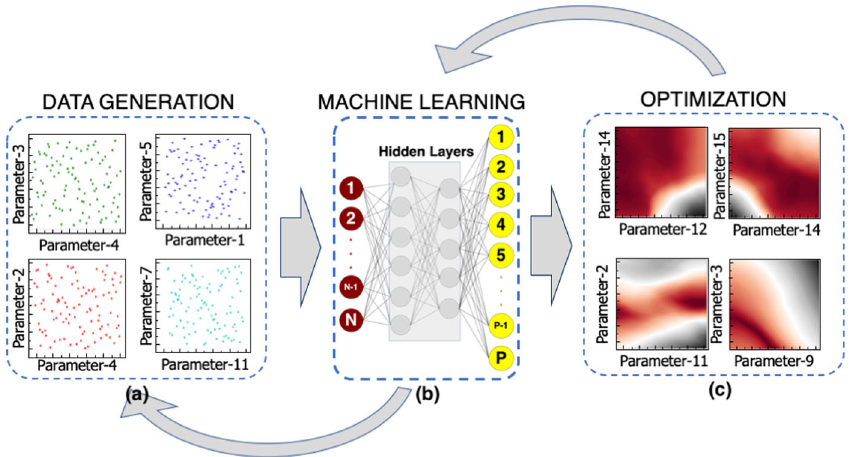
Fig. 1 Schematic representation of the optimization framework. Schematic representation of the DL-based optimization procedure. a Representation of the sampling using the initial design algorithm. b Deep neural network structure, red circles are input nodes, yellow circles are output nodes, and grey circles are hidden layer nodes. c Representation of the parameter-discrepancy correlation in parameter space.